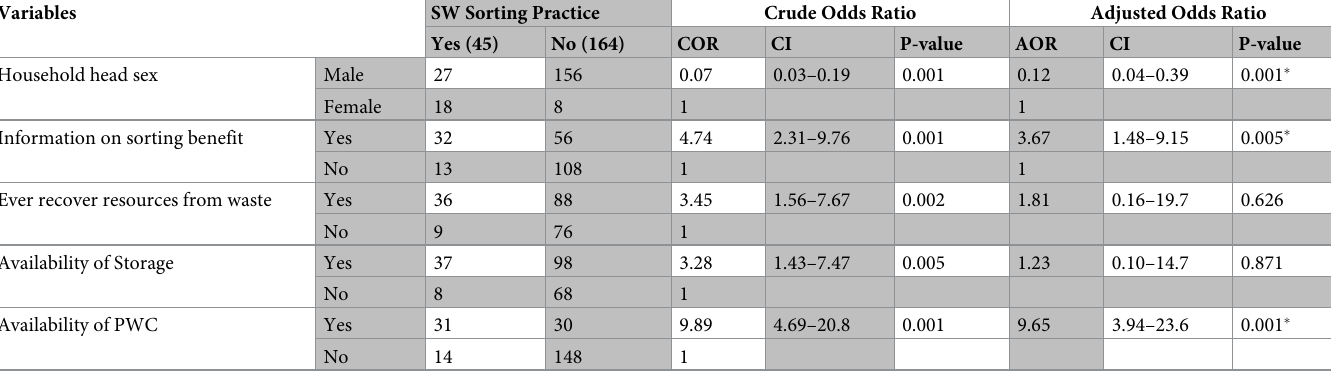
Table 3. Multivariable analysis of point of source waste sorting practice among households in Beddele, southwest, Ethiopia, 2021. Variables